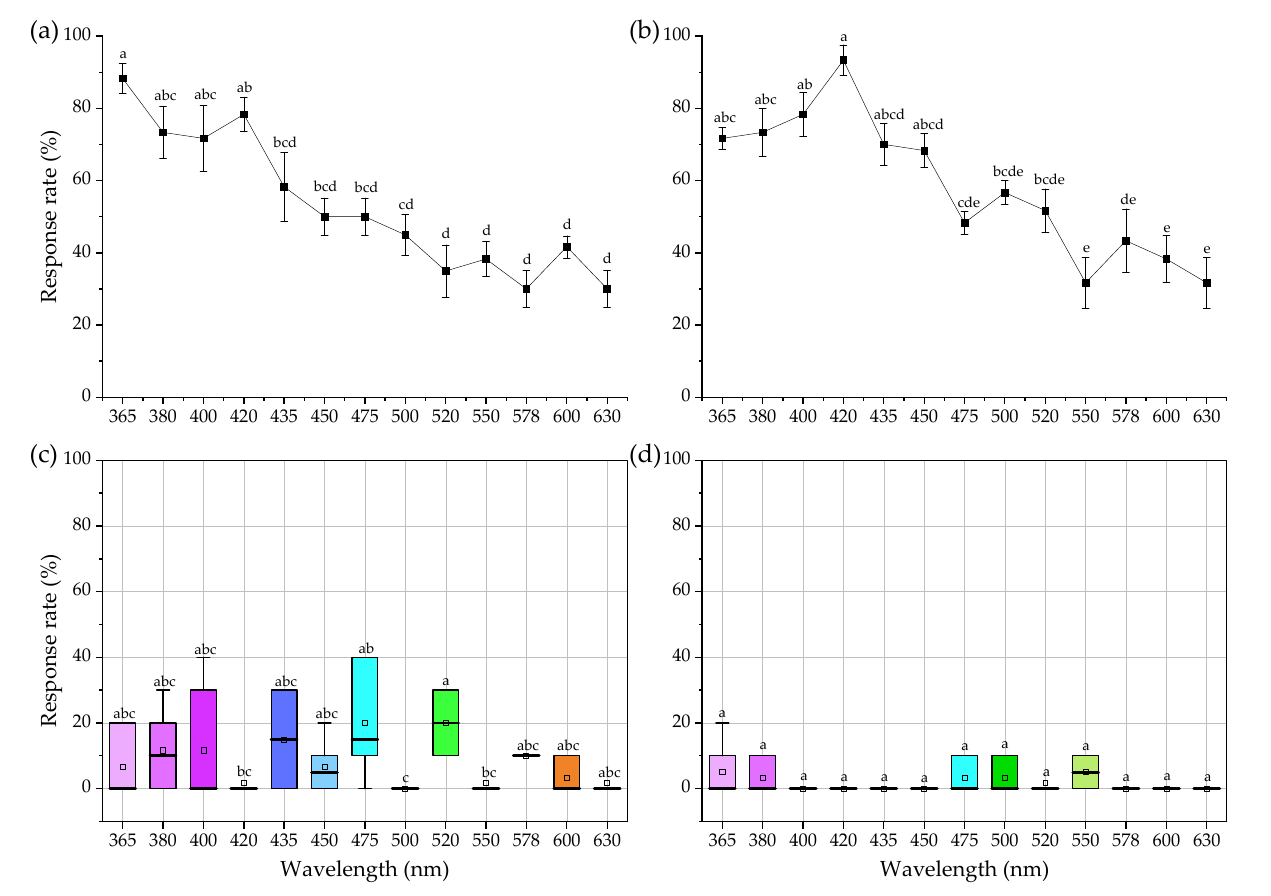
Figure 2. Behavioral responses of females and males of Exolontha castanea to different wavelengths. ( a ) Phototactic behavior of females; ( b ) Phototactic behavior of males; ( c ) Photophobic behavior of females; ( d ) Photophobic behavior of males. ( a , b ) Data are means ± SE, different lowercase letters indicate significant differences between wavelengths (Tukey’s HSD test, p < 0.05). ( c , d ) The upper and lower sides of the box plot are 75% and 25% quantiles, respectively. The line in the middle of the box represents the median of the data. The square are mean. Different lowercase letters indicate significant differences between wavelengths (Kruskal–Wallis test, p < 0.05).